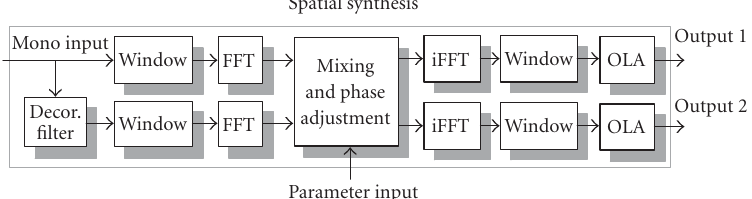
Figure 5: Spatial synthesis stage of the